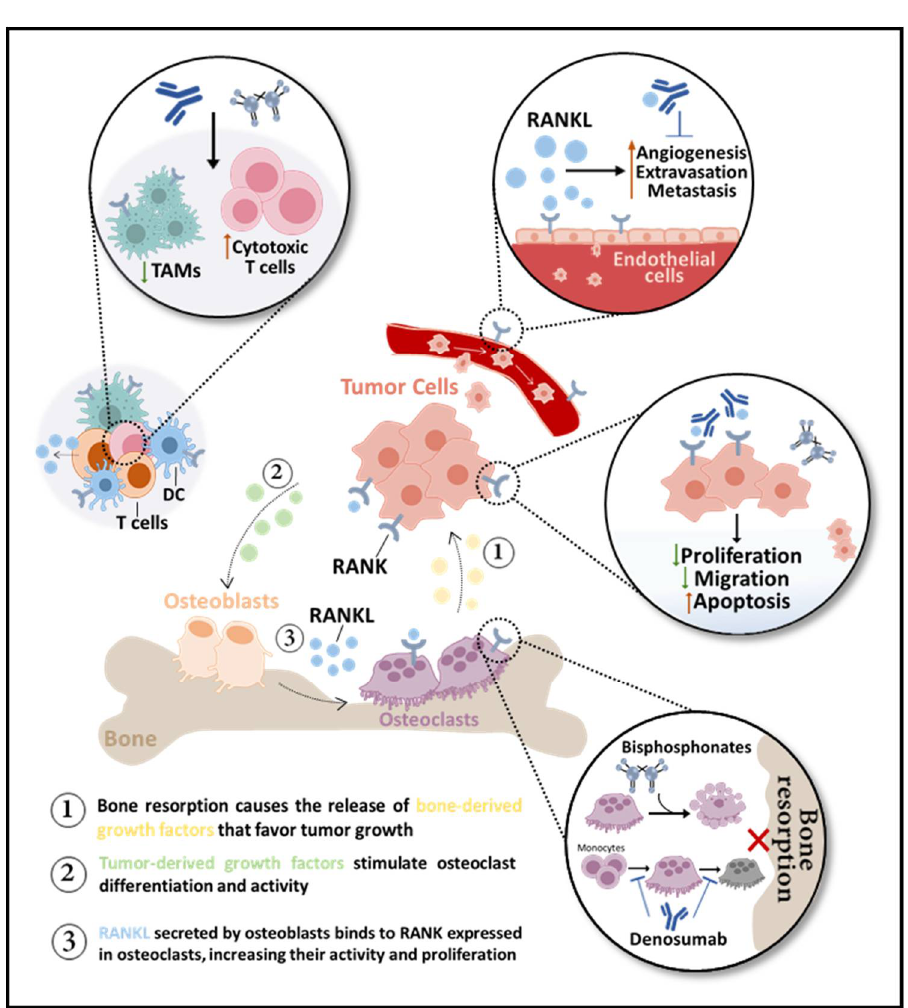
Figure 2. RANKL inhibition in bone metastases (BM). Bone-targeted agents (BTAs) are used to control BM by impairing bone resorption, indirectly affecting the tumor burden. While bisphosphonates only affect mature osteoclasts, inducing apoptosis, the anti-RANKL antibody denosumab prevents osteoclast differentiation, activity, and survival. Denosumab may also be antiangiogenic over RANK-positive endothelial cells. RANK is expressed in dendritic cells (DC) and macrophages, like tumor-associated macrophages (TAMs), and T-cell derived RANKL inhibition decreases TAMs and increases cytotoxic T cells. Potential direct effects of BTAs in tumor cells include inhibition of proliferation and migration and induction of apoptosis.